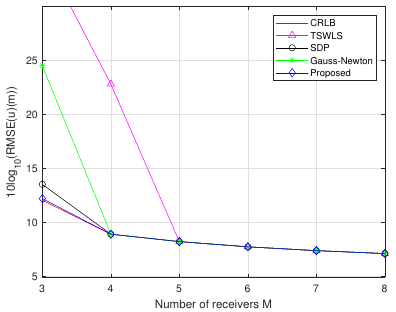
Figure 8. RMSE comparison for estimating target position at σ 2 = 100 m 2 and σ 2 s = 1 m 2 using three